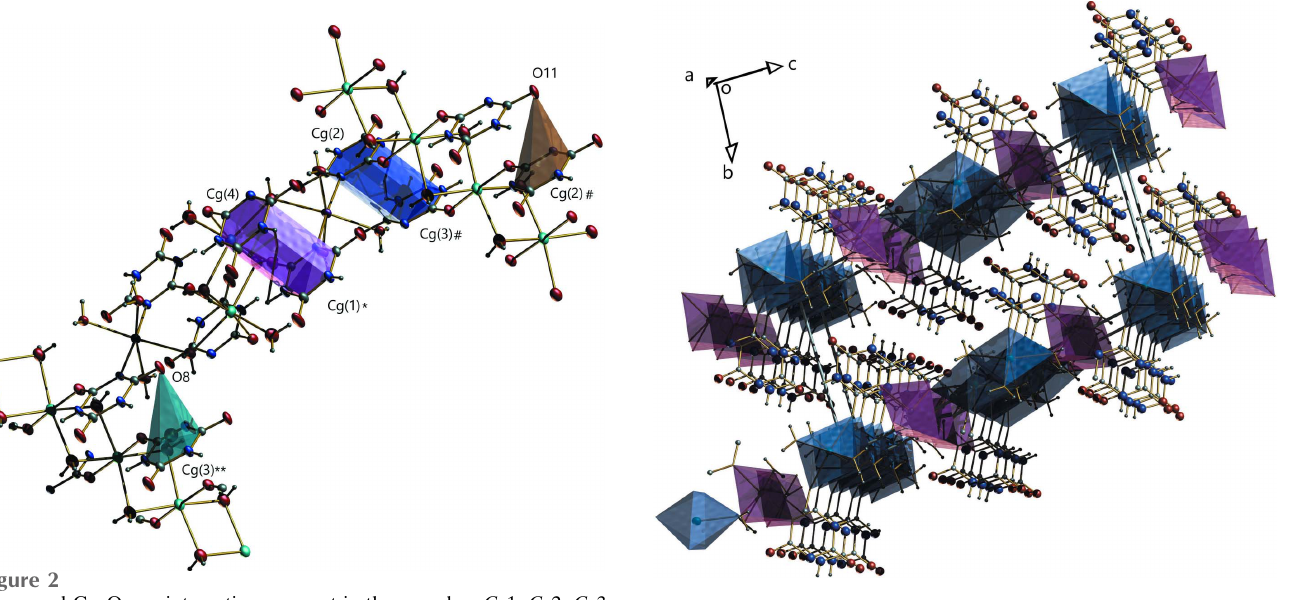
Figure 3 The packing, viewed down the a axis, showing the coordination